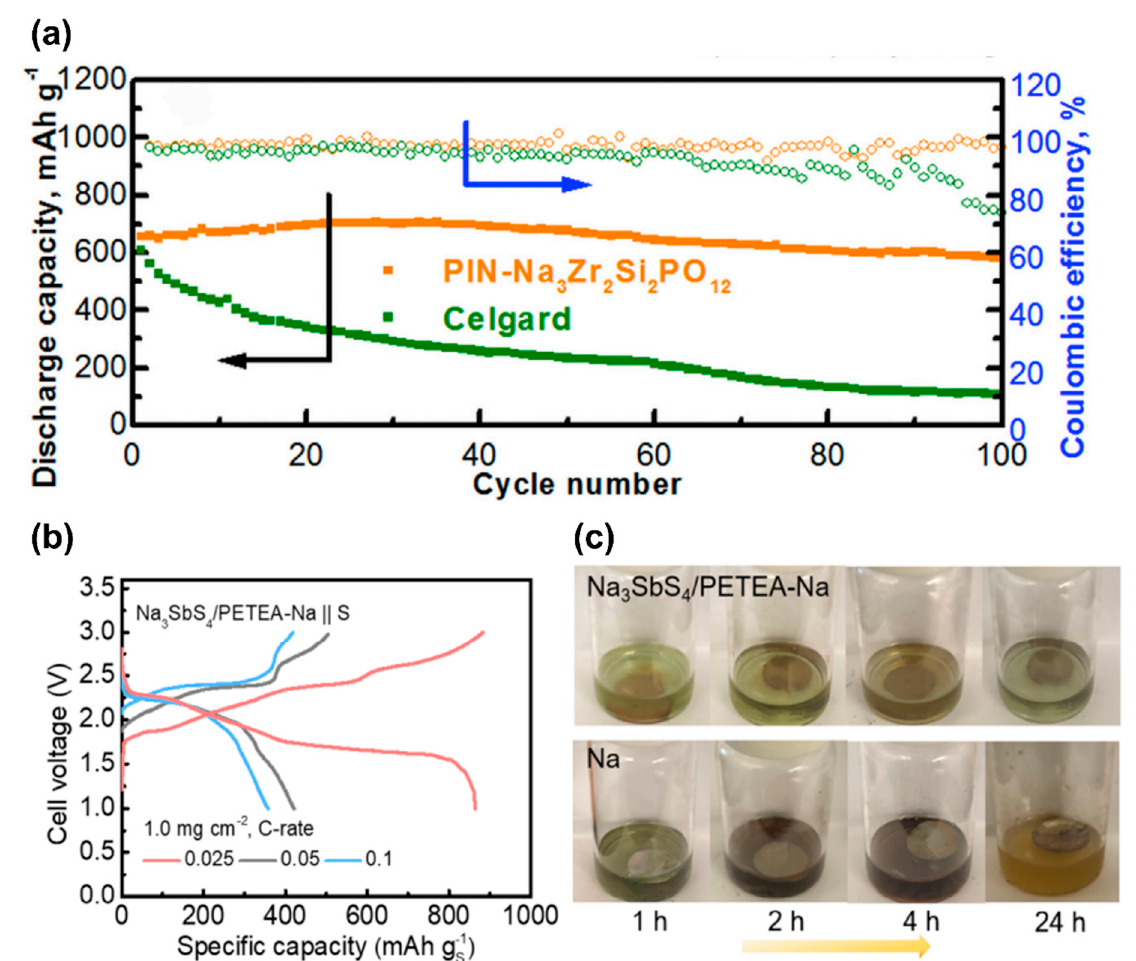
Figure 8. ( a ) Cycle performance of Na ǁ PIN-Na 3 Zr 2 Si 2 PO 12 ǁ CNF/S cell. Reproduced with permission [149]. Copyright 2019, Cell Press. ( b ) Voltage pro fi les of Na 3 SbS 4 /PETEA − Na ǁ S cells at various current rates, and ( c ) visual observation of changes in Na 3 SbS 4 /PETEA − Na and bare Na soaked in the liquid electrolyte containing sulfur powder. Reproduced with permission [150]. Copyright 2021, American Chemical Society.